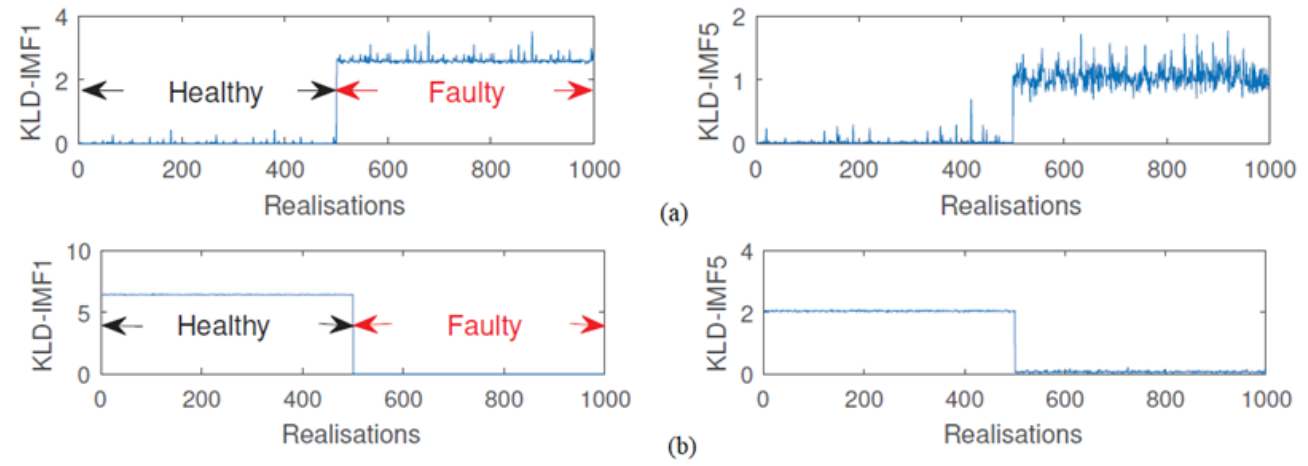
Figure 23. Ball bearing results based on EMD at ( a ) 0% loading conditions and ( b ) 100% loading conditions. Reproduced with permission of [67].